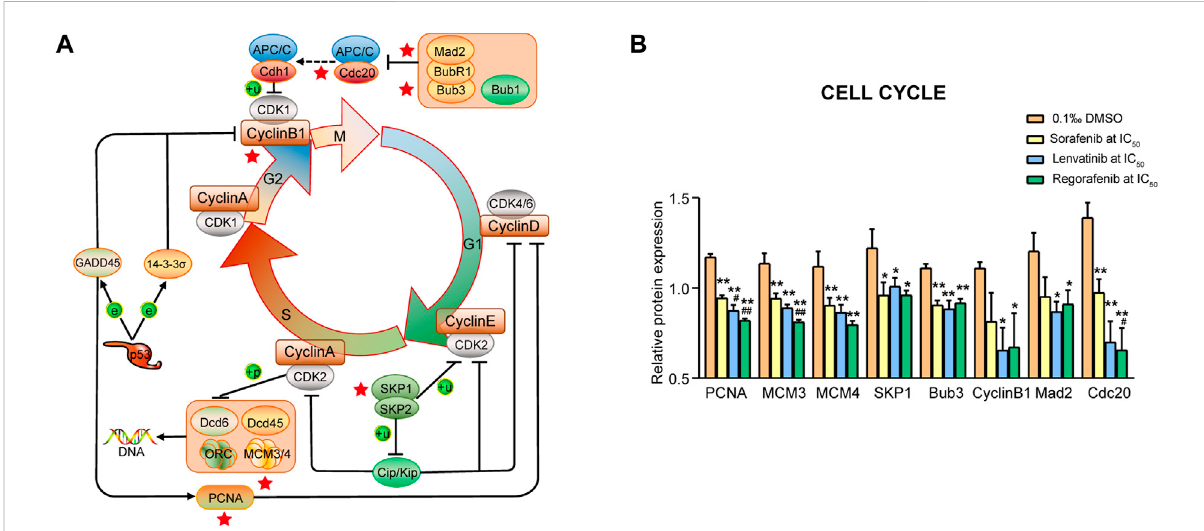
FIGURE 6 Commonly downregulated proteins involved in the cell cycle signaling pathway (A) and their relative expression (B) in Huh-7 cells treated by 72 h incubation with respective sorafenib, lenvatinib and regorafenib. Each bar presents mean ± SD ( n = 3). The * p < 0.05 and ** p < 0.01 versus DMSO; # p < 0.05 and ## p < 0.01 versus sorafenib. Star symbol in red color indicating the downregulation of the